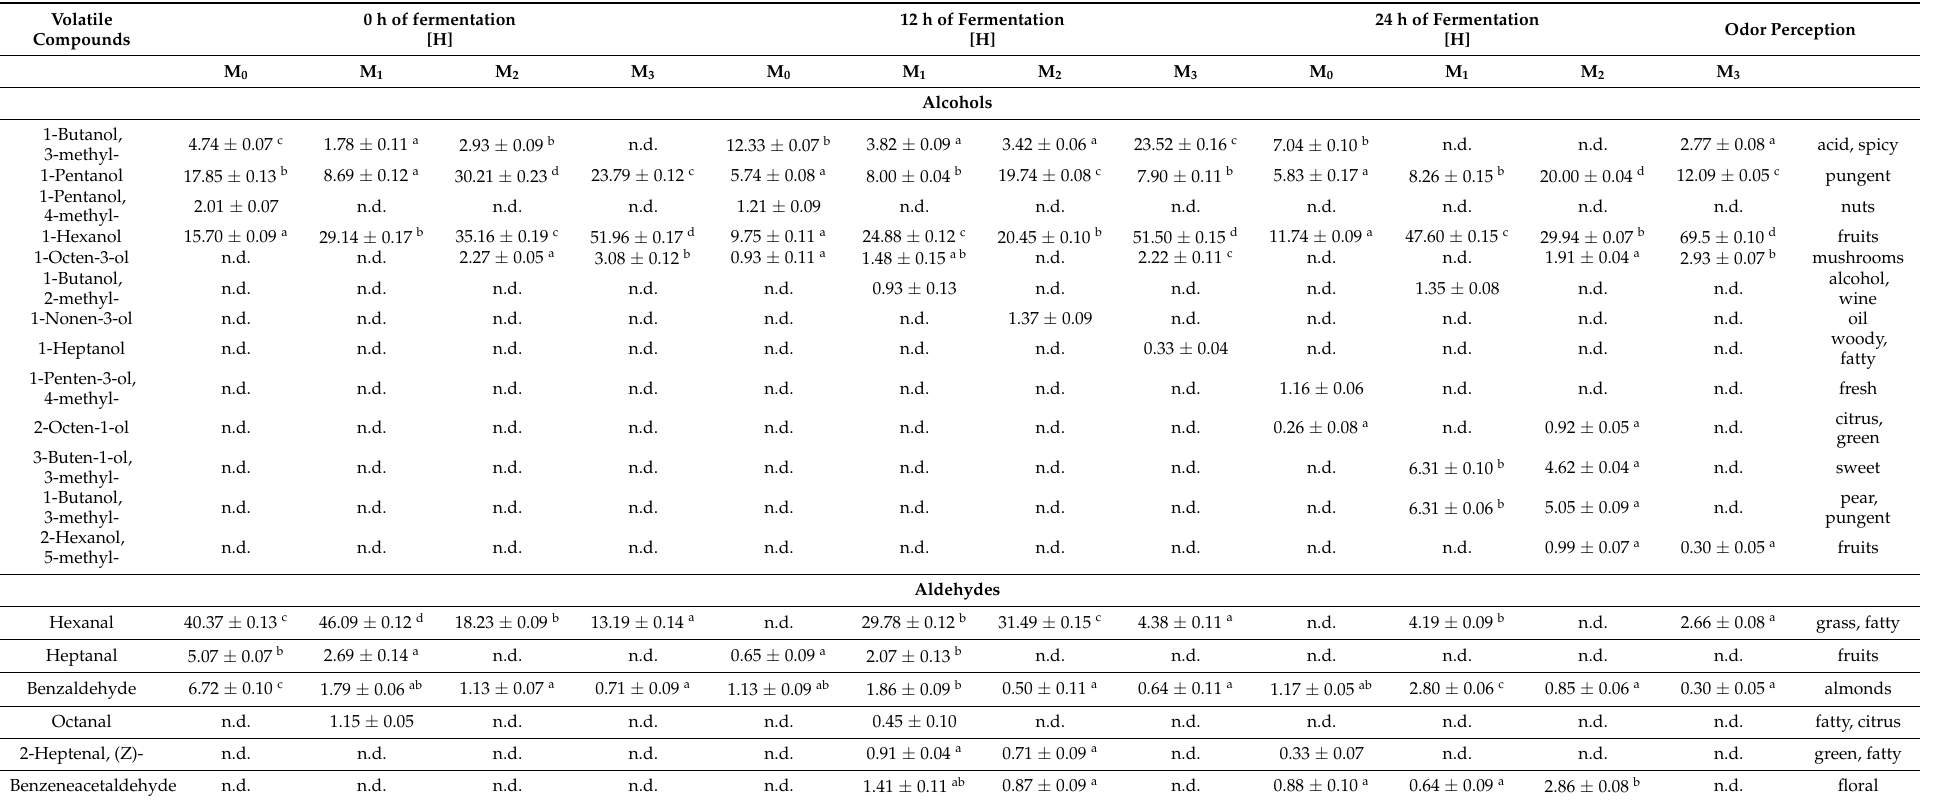
Table 5. Volatile compounds in sourdough with wheat flour (M 0 ), einkorn flour (M 1 ), spelt flour (M 2 ), and emmer flour (M 3 ), fermented for 0, 12, and 24 h with Lactiplantibacillus plantarum ATCC